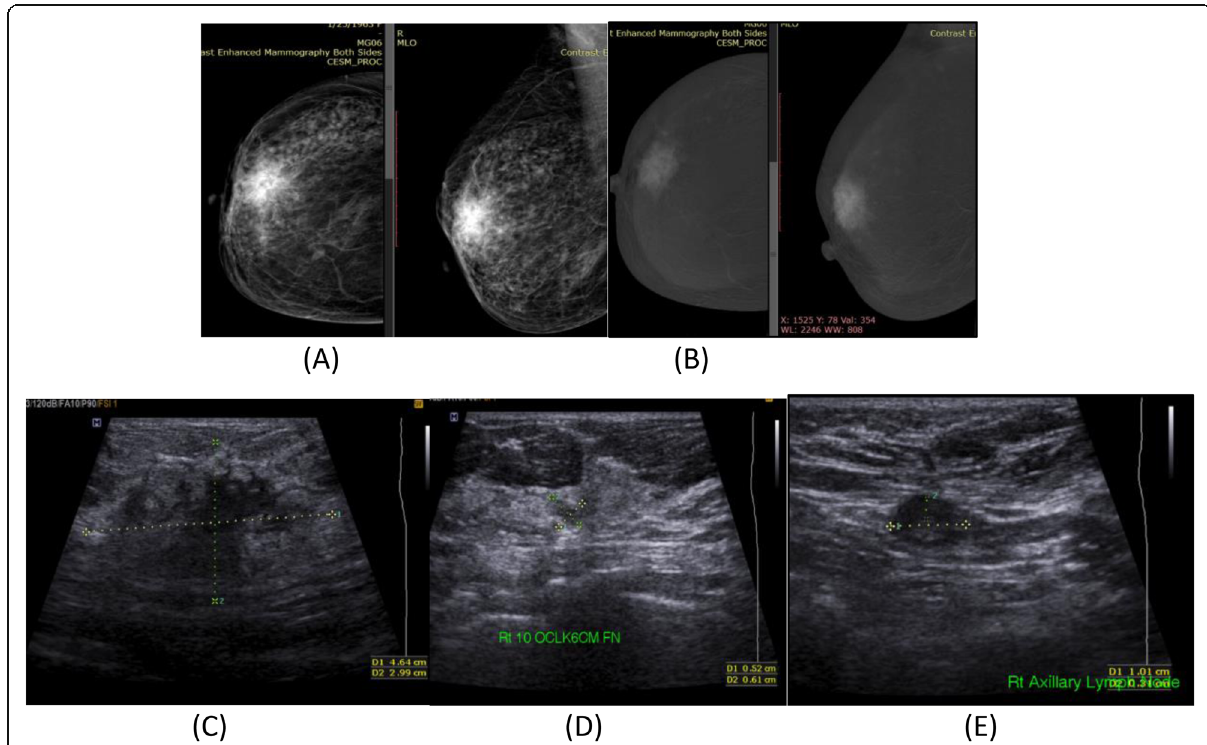
Fig. 2 56-year-old female patient with right palpable lump. A Low-energy CEDM, MLO, and CC views of the right side showed retroareolar irregular spiculated mass lesion. B Recombined CEDM image showed avid enhancement of that lesion, with other enhancing nodules seen in the upper outer quadrant. C Targeted ultrasound examination revealed irregularly shaped spiculated hypoechoic mass lesion and another smaller one at the upper outer quadrant corresponding to the enhancing nodule detected. D Suspicious thickened cortex axillary lymph node is noted as well. E Histopathology revealed invasive lobular carcinoma (ILC)